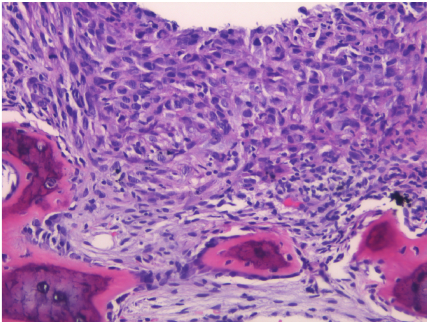
Figure 3: Needle core biopsy, H&E 20x: bone involved by malignant pleomorphic and spindled